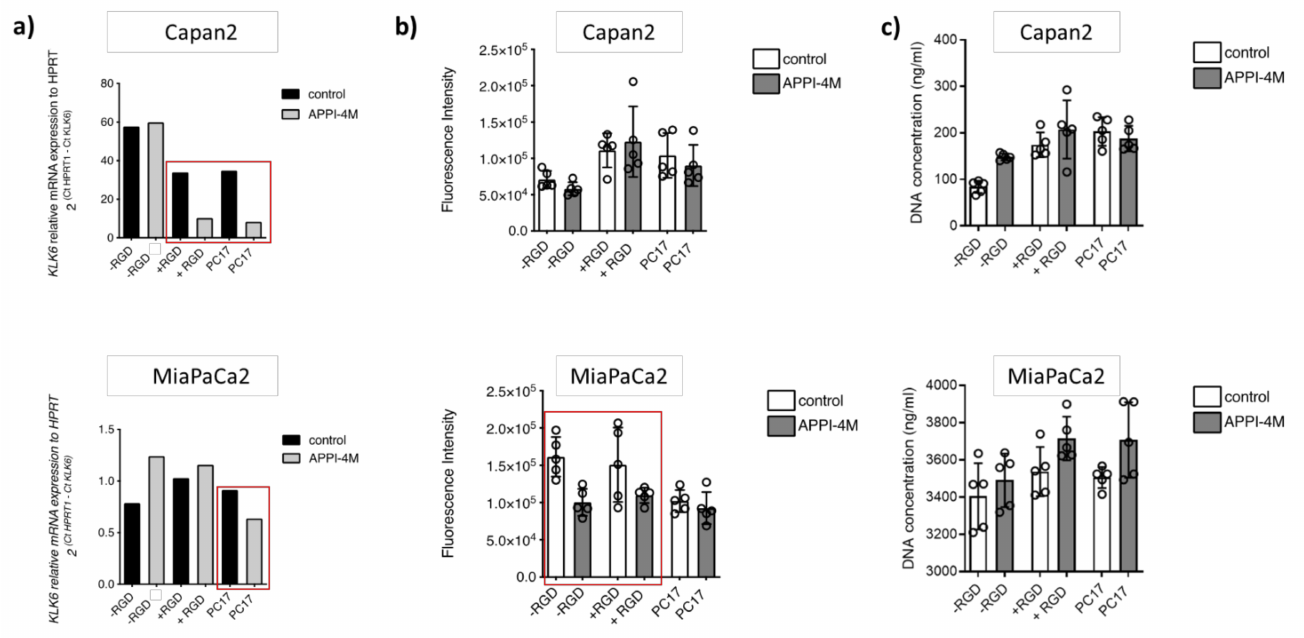
Figure 5. Effect of the APPI-4M KLK6 inhibitor on tumour spheroids. ( a ) KLK6 inhibition reduced the mRNA expression of Capan2 and MiaPaCa2 cells grown in PC17 and RGD-functionalised hydrogels (red boxes). ( b ) KLK6 inhibition reduced the metabolic activity (represented as fluorescence intensity) of MiaPaCa2 cells grown in RGD-functionalised hydrogels and hydrogels without RGD motif (red box). ( c ) KLK6 inhibition slightly increased cell proliferation (represented as DNA concentration) within all hydrogels